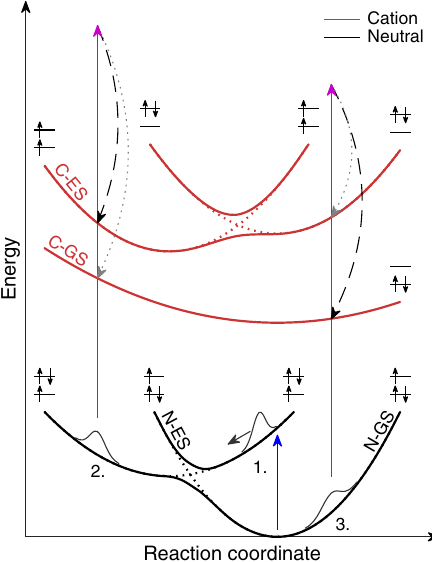
Fig. 1 General working principle of extreme-ultraviolet time-resolved photoelectron spectroscopy. The fi gure shows a set of neutral and cationic potential energy surfaces in adiabatic (solid) and diabatic representations (dashed). At position 1, a WP is generated in the Franck-Condon region of the fi rst exicted state of the neutral (N-ES) with a UV pump photon (blue arrow). As the excited-state WP moves along the potential surface, the vertical I p to the cationic groundstate (C-GS) and the fi rst cationic excited state (C-ES), never exceeds the XUV photon energy (violet arrow). During the propagation of the WP, the electronic character changes (depicted as the leading electronic con fi gurations), therefore changing the electronic overlap between neutral and cationic states. At position 2, the transition to the C-GS is Koopmans forbidden (dotted gray arrow) while the transition to the C-ES is allowed (dashed black arrow). Upon relaxation of the WP to the ground-state of the neutral (N-GS), the effect is inverted (position